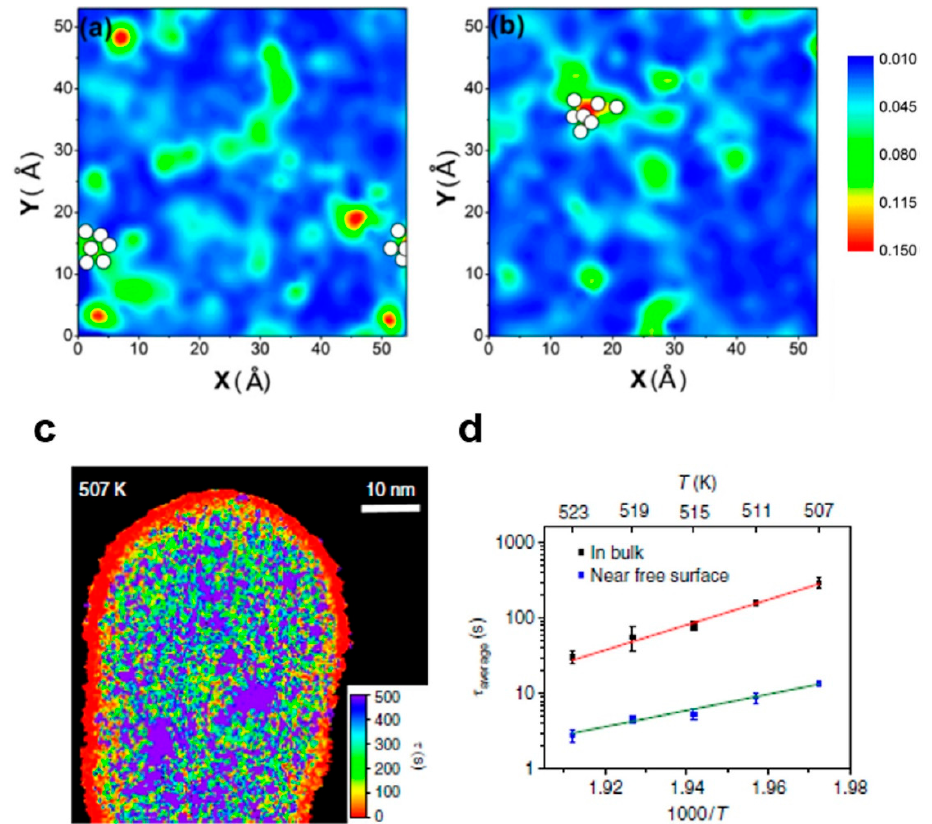
Figure 2. ( a , b ) Contour maps show the spatial distribution of participation fraction in soft vibrational modes. White spots superimposed on the maps mark the locations of atoms that have experienced the most (top 5%) accumulative non-affine displacement. Reproduced from [62], with permission of PNAS, 2016. ( c ) Spatial maps of structural relaxation times in a nanowire in the supercooled liquid regime at T = 507 K. ( d ) The mean structural relaxation time for the nanowire interior (bulk) and the near-surface layer. Reproduced from [11], with permission of Nature Communications, 2018.